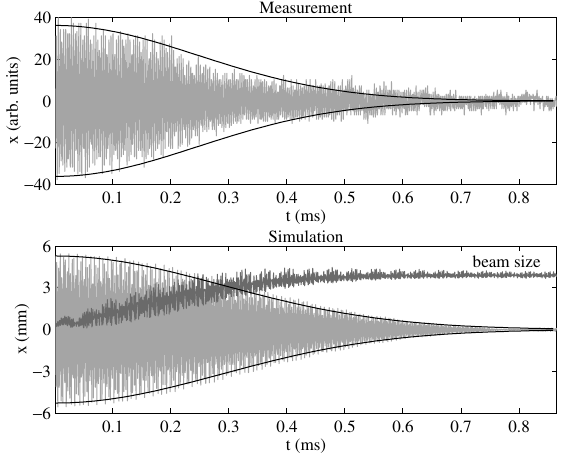
FIG. 2. Gaussian damping of the coherent